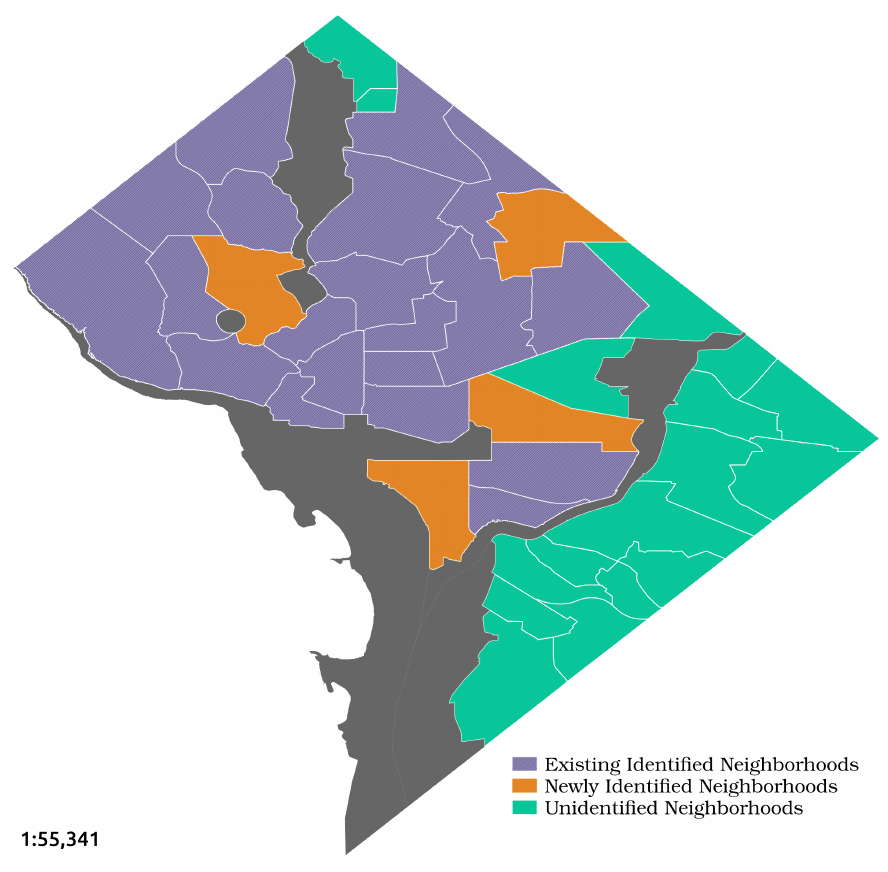
Figure 6. Identified and unidentified neighborhoods in Washington, DC. Figure 5. Identified and unidentified neighborhoods in Washington,